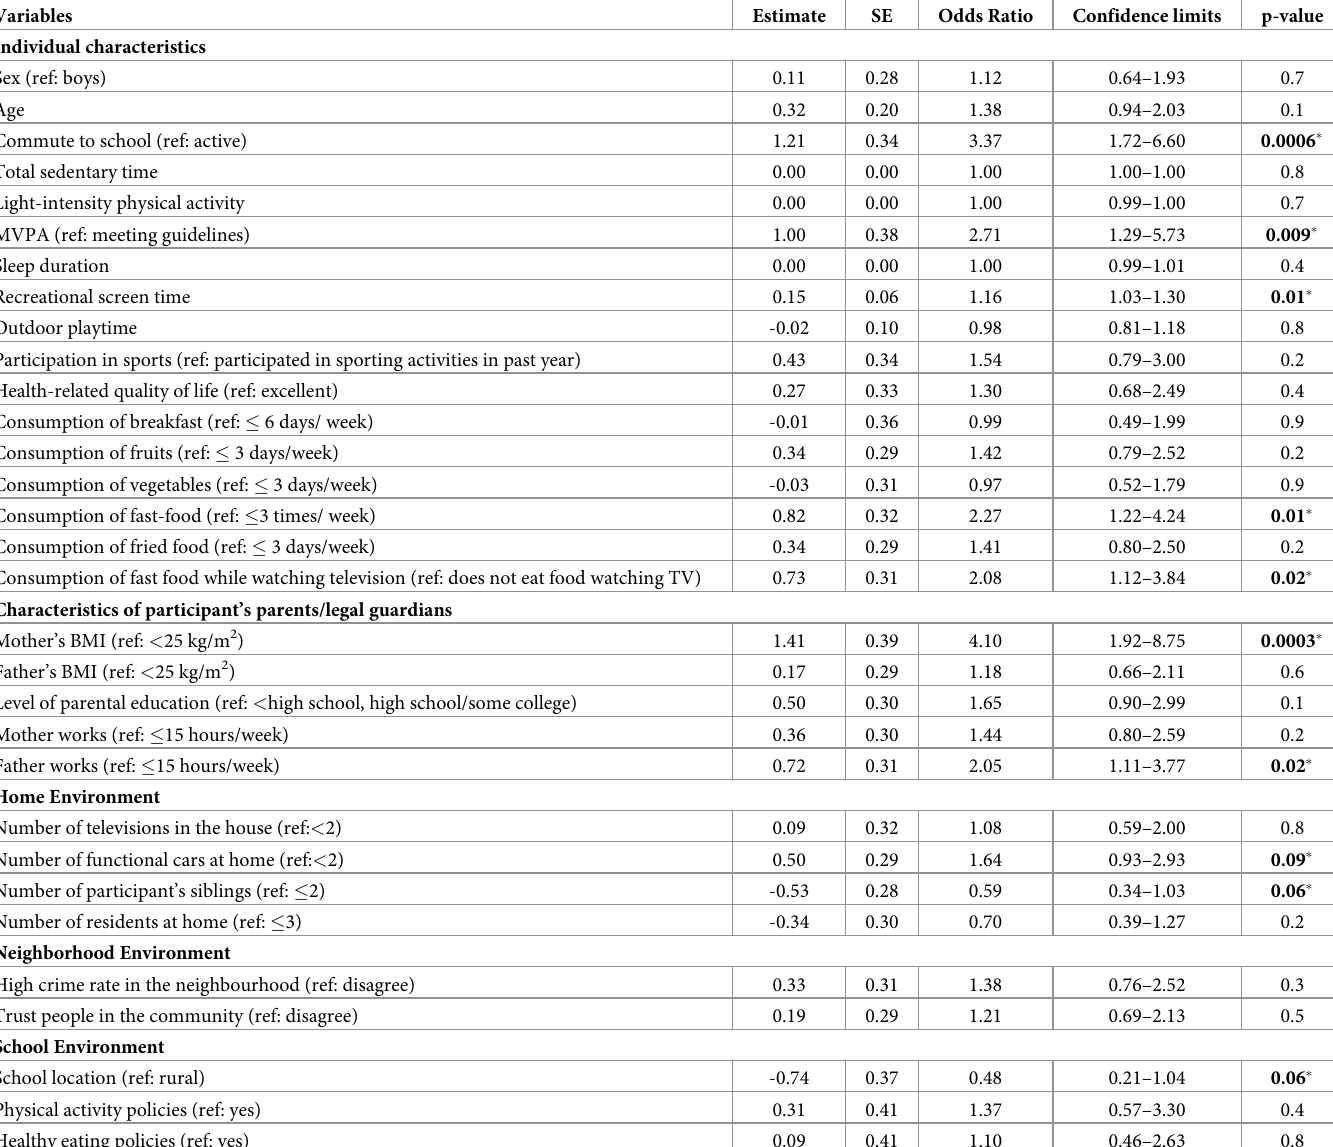
Table 3. Univariate correlates of